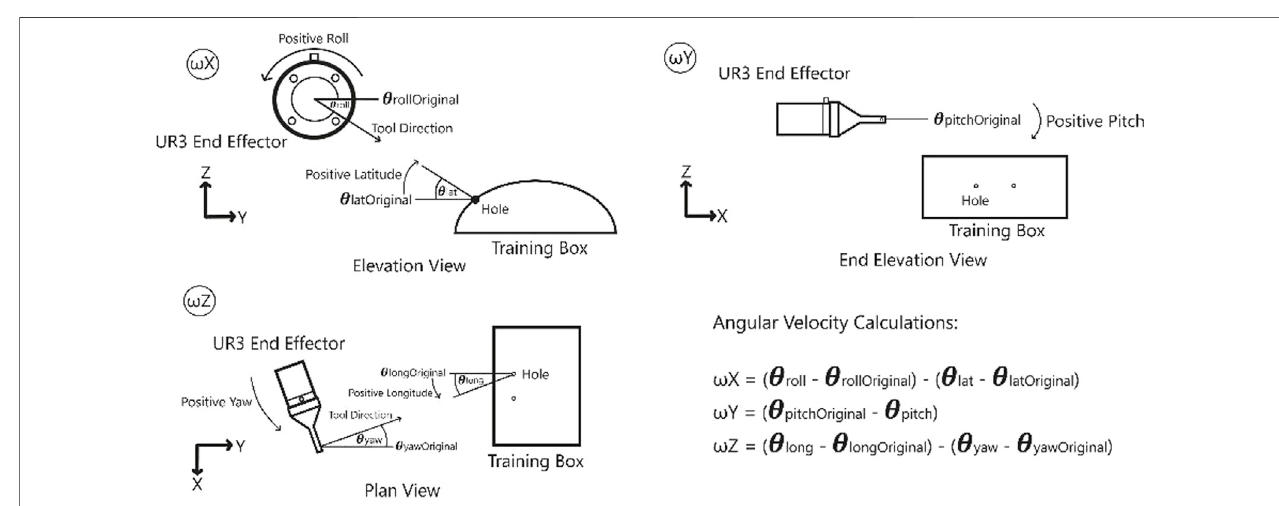
FIGURE 5 | Coordinates used for the calculations of the linear and angular velocities of the robot.